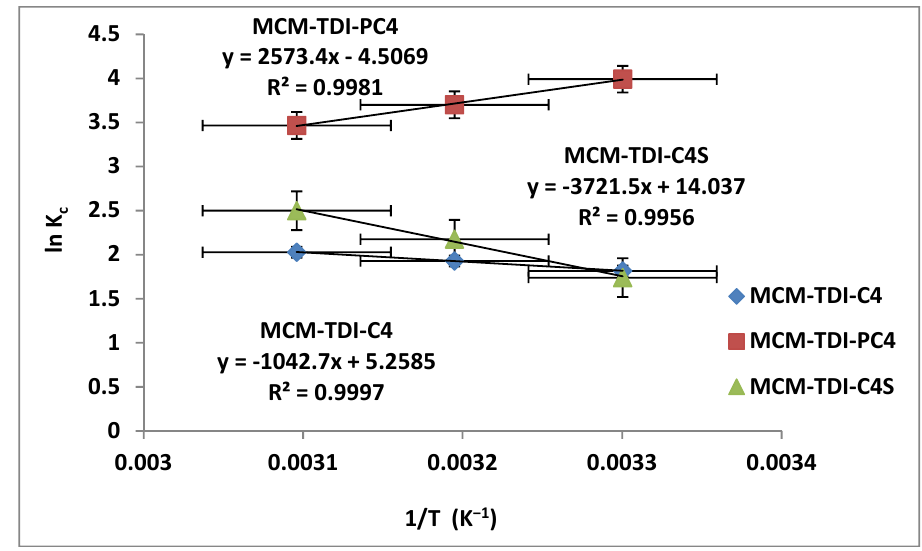
Figure 11. Plot of lnK versus 1/T for MCM-TDI-C4, MCM-TDI-C4S and c